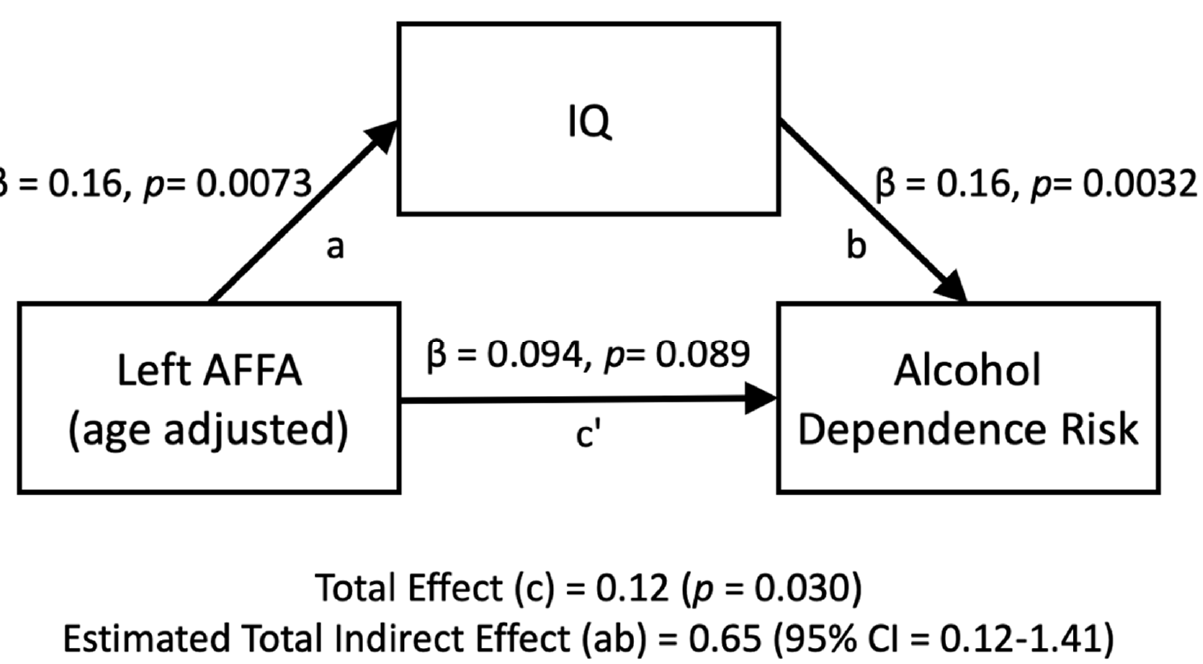
Figure 4. Mediation analyses for the left AFFA (age-adjusted) on the number of alcohol dependence risk, directly (c’) and indirectly through IQ (ab).